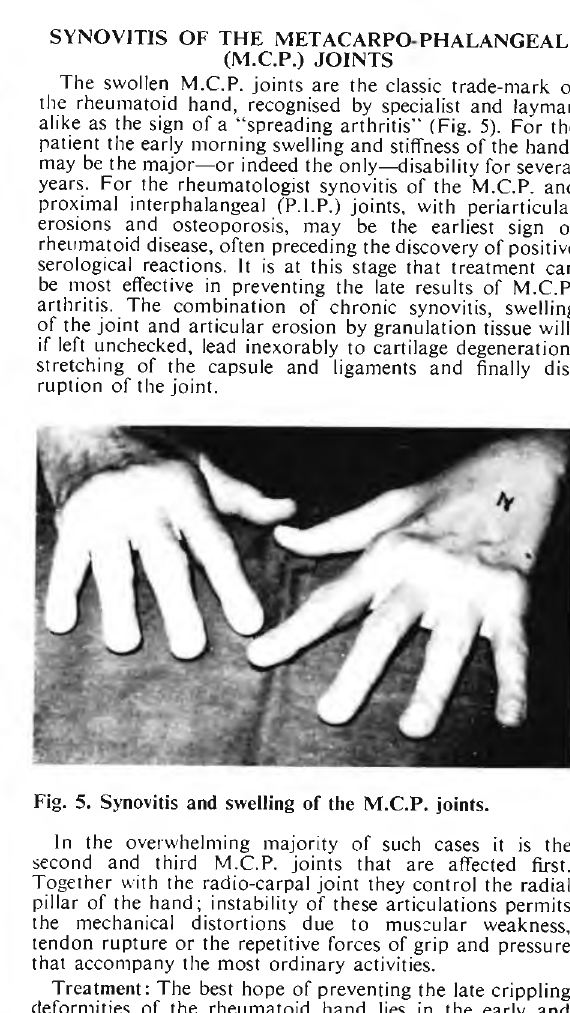
Fig. 4. The late effects of rheumatoid arthritis. Radiograph showing destruction of the carpus.